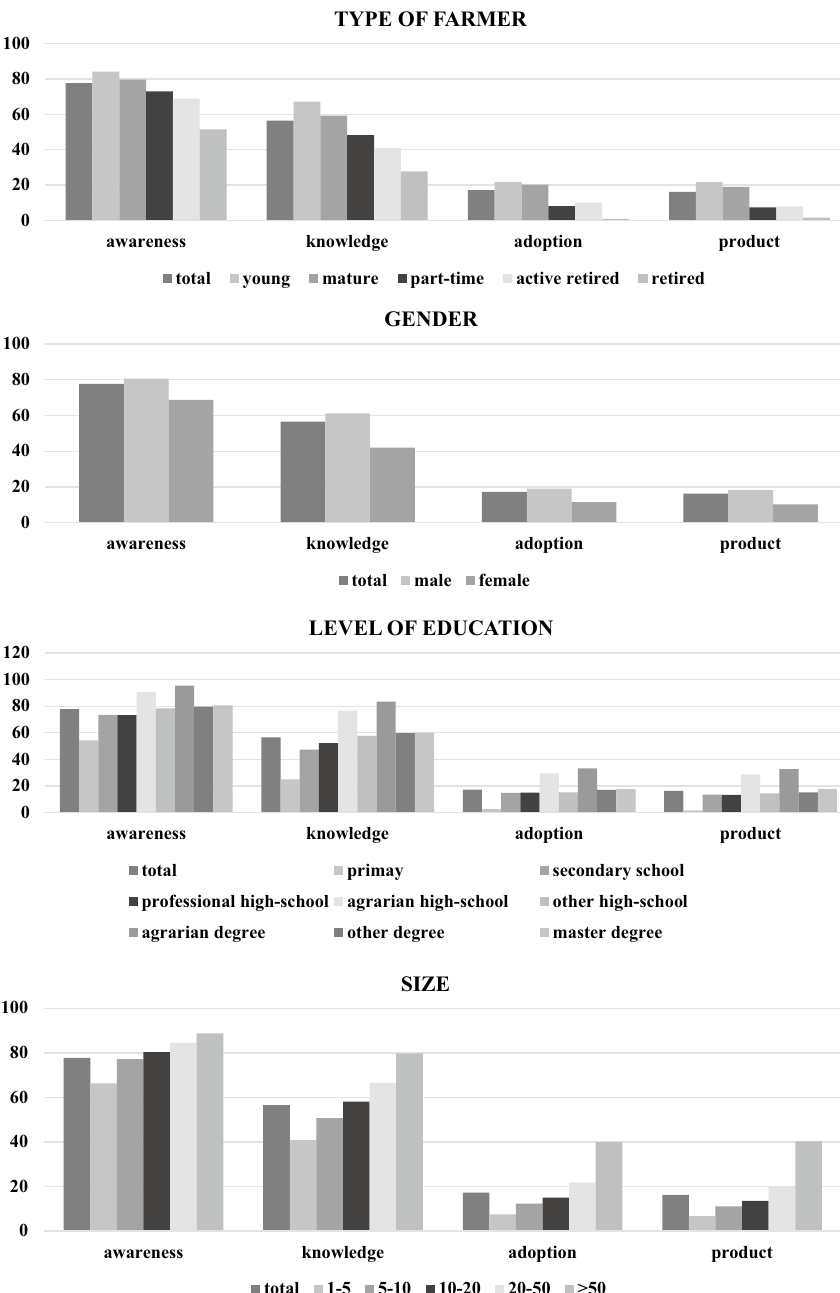
Fig. 3 AKAP sequence for the socio-structural